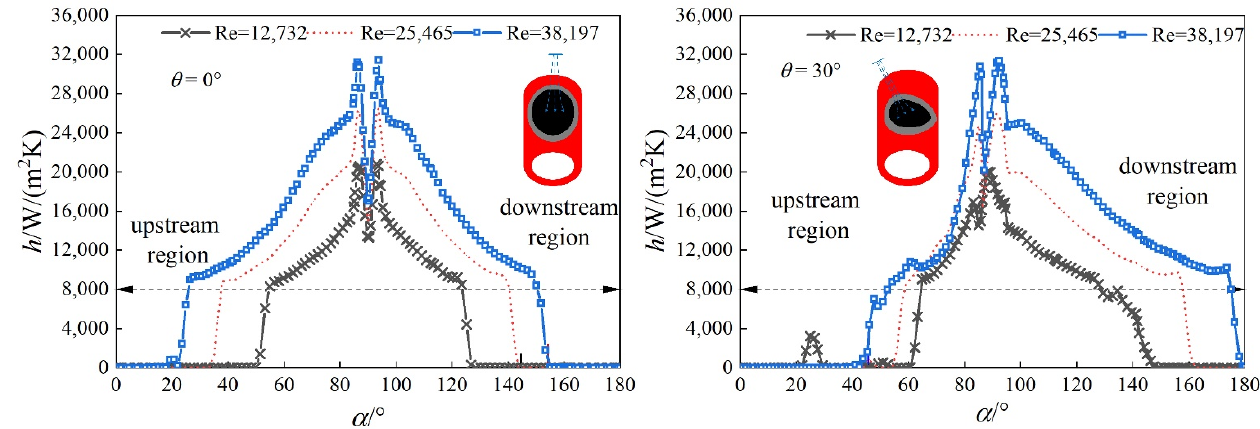
Figure 12. Distribution of the local convective heat transfer coefficient ( h ) along the circumferential direction angle ( α ) of steel tubes under different Reynolds numbers.